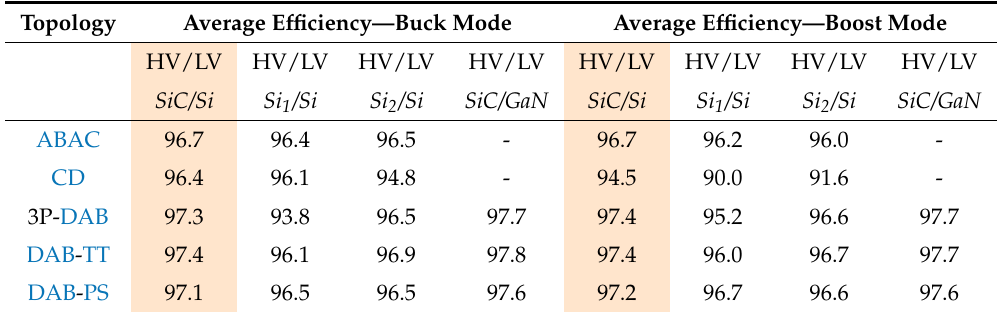
Table 9. Average efficiency comparison between different switches technologies. Optimized proposed solution is highlighted in orange. Topology Average Efficiency—Buck